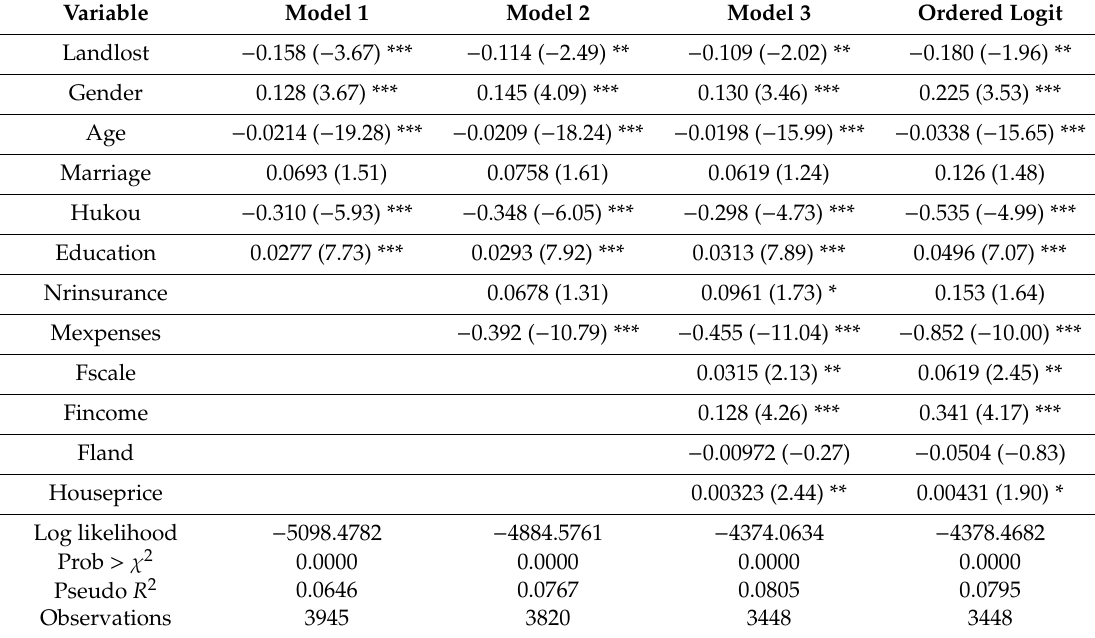
Table 2. Results: ordered probit model estimating health